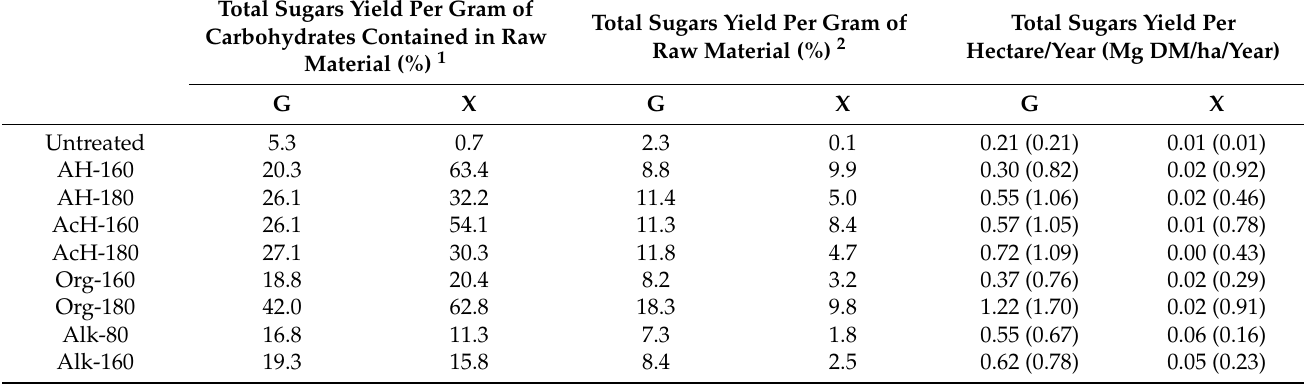
Table 6. Total sugars yield per gram of carbohydrates contained in raw material, total sugars yield per gram of raw material and total sugars yield per hectare/year of Ademuz elm